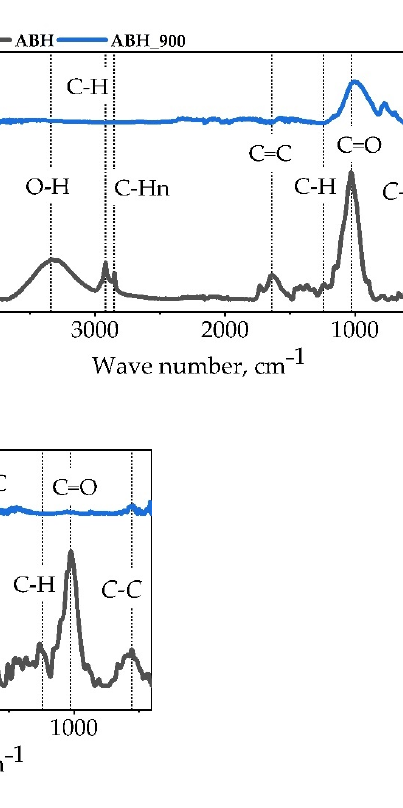
Figure 6. FTIR spectrum of ( a ) ABW, ( b ) ABH and ( c ) WBP.